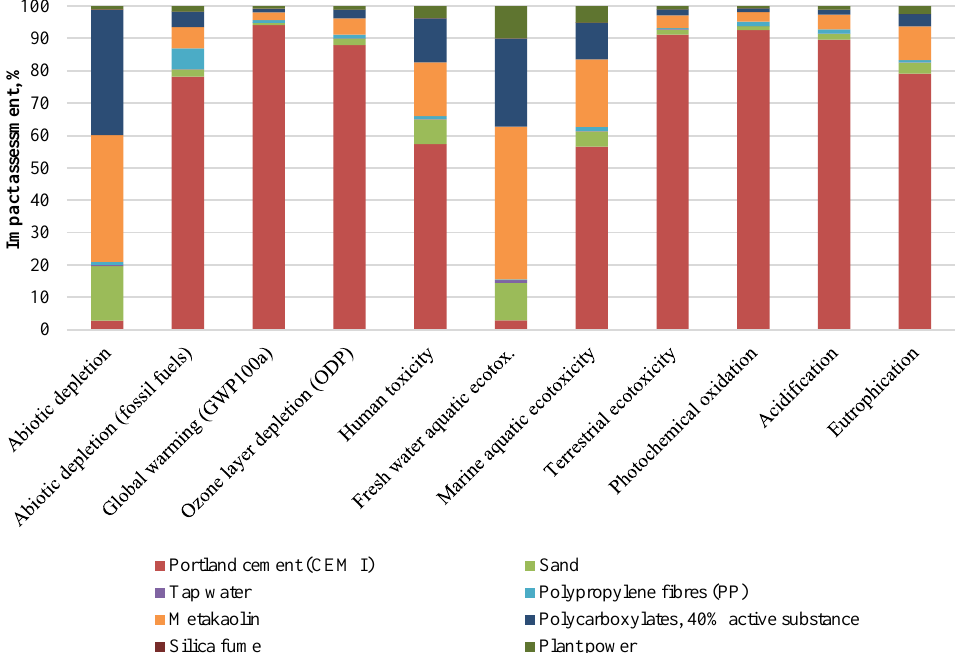
Fig. 3. Foam concrete FC-12.5 impact assessment by CML-IA baseline